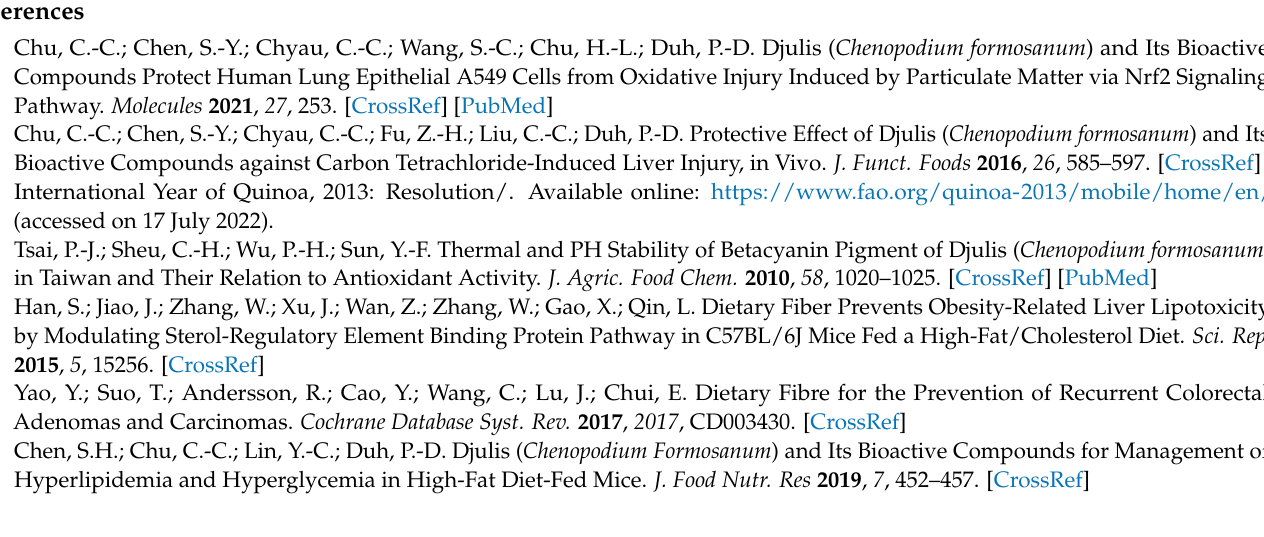
significant differences from each